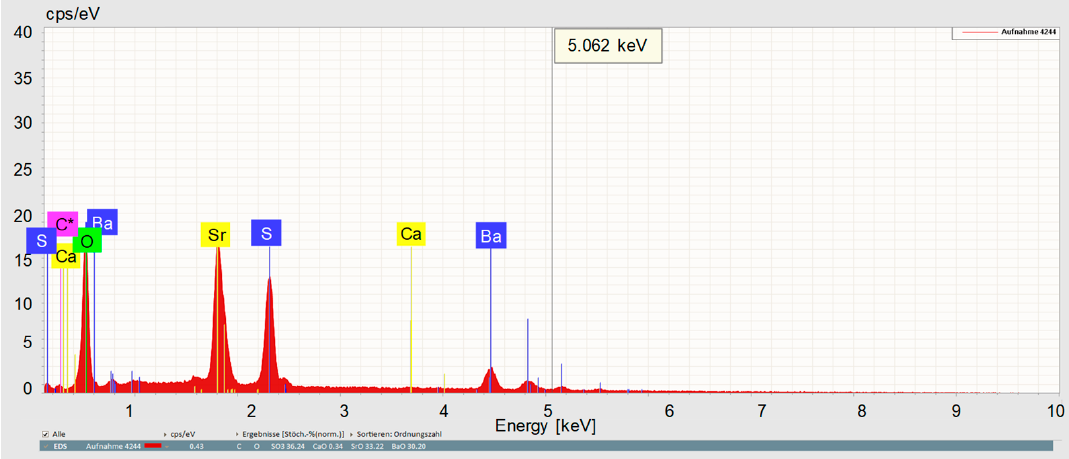
Figure 18. Spectrum of the sulfate crystal S1 shown in Figure 17. Metals 2020 , 10 , x FOR PEER REVIEW